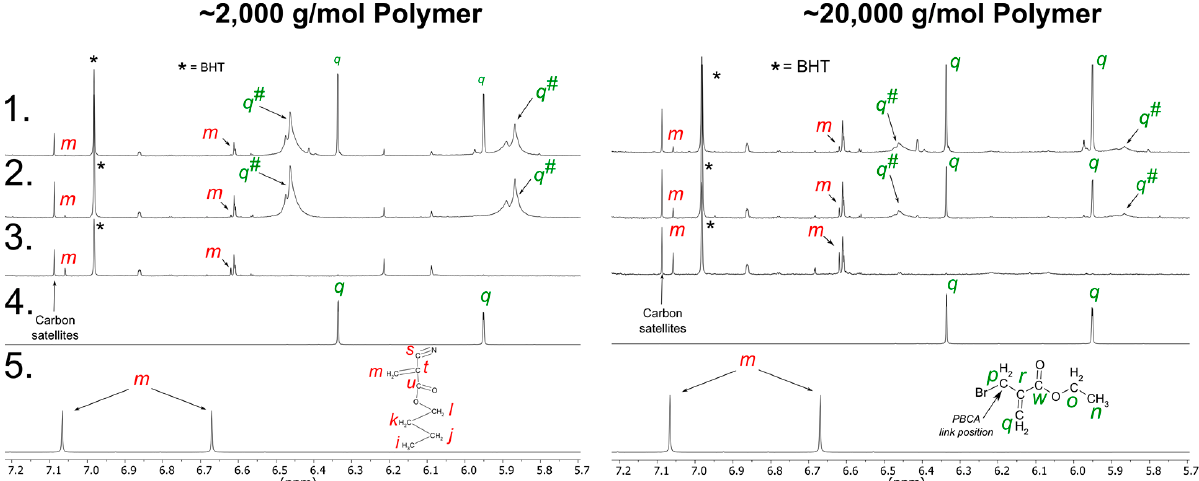
Figure 8. The 600 MHz 1 H NMR spectra of the olefinic region. ( Left ): ~2000 g/mol tPBCA using 25 mM EBMA as terminator ( 1 ), ~2000 g/mol tPBCA using 5 mM EBMA ( 2 ), ~2000 g/mol PBCA as comparison ( 3 ), neat EBMA ( 4 ) and BCA monomer ( 5 ). ( Right ): ~20,000 g/mol tPBCA using 25 mM EBMA ( 1 ), ~20,000 g/mol tPBCA using 5 mM EBMA ( 2 ), ~20,000 g/mol PBCA as comparison ( 3 ), neat EBMA ( 4 ) and BCA monomer ( 5 ).